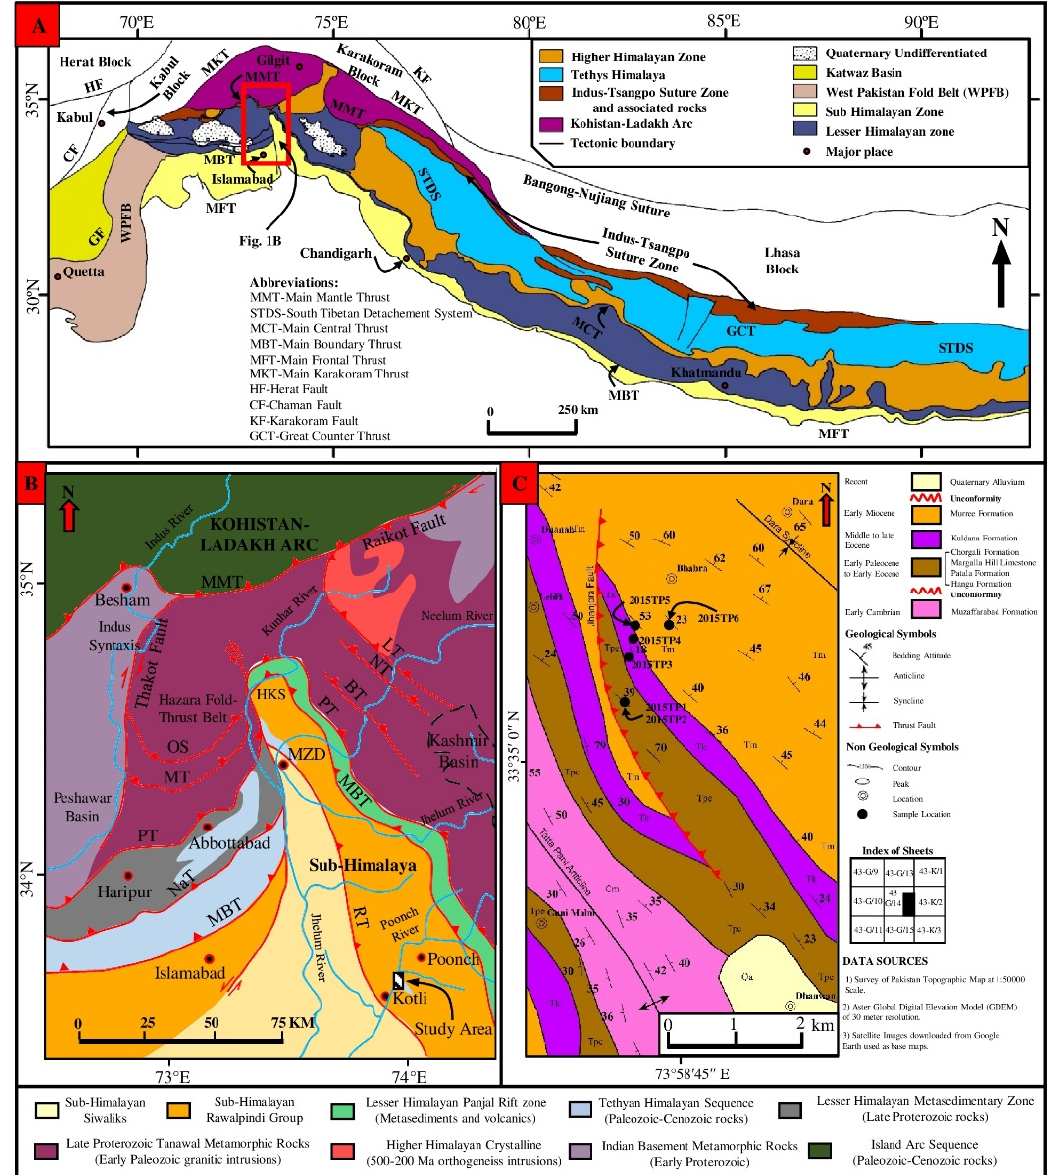
Figure 1. ( A ) Generalized Tectonic map showing major tectonostratigraphic zones (modified after Qasim et al., [17] and based on many sources references therein). The red rectangle shows the extent of Figure 1B. ( B ) Simplified Tectonic map of Hazara-Kashmir syntaxis and surrounding areas (after Qasim et al. [17] and references therein). The hatched black rectangle shows the location of the studied area. MMT—Main Mantle Thrust, LT—Laut Thrust, NT—Neelum Thrust, BT—Barian Thrust, PT—Panjal Thrust, HKS—Hazara Kashmir Syntaxis, MBT—Main Boundary Thrust, MZD—Muzaffarabad, OS—Oghi Shear zone, MT—Mansehra Thrust, NaT—Nathia Gali Thrust and RT—Riasi Thrust. ( C ) Geological and structural map of the studied area showing stratigraphic units and location of samples collected for U-Pb geochronology.